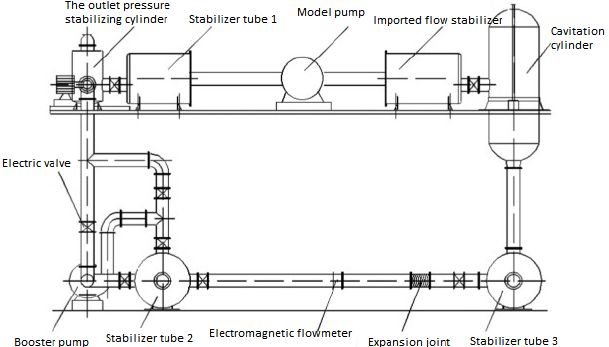
Figure 13. Multifunctional vertical pump closed test bench [76].